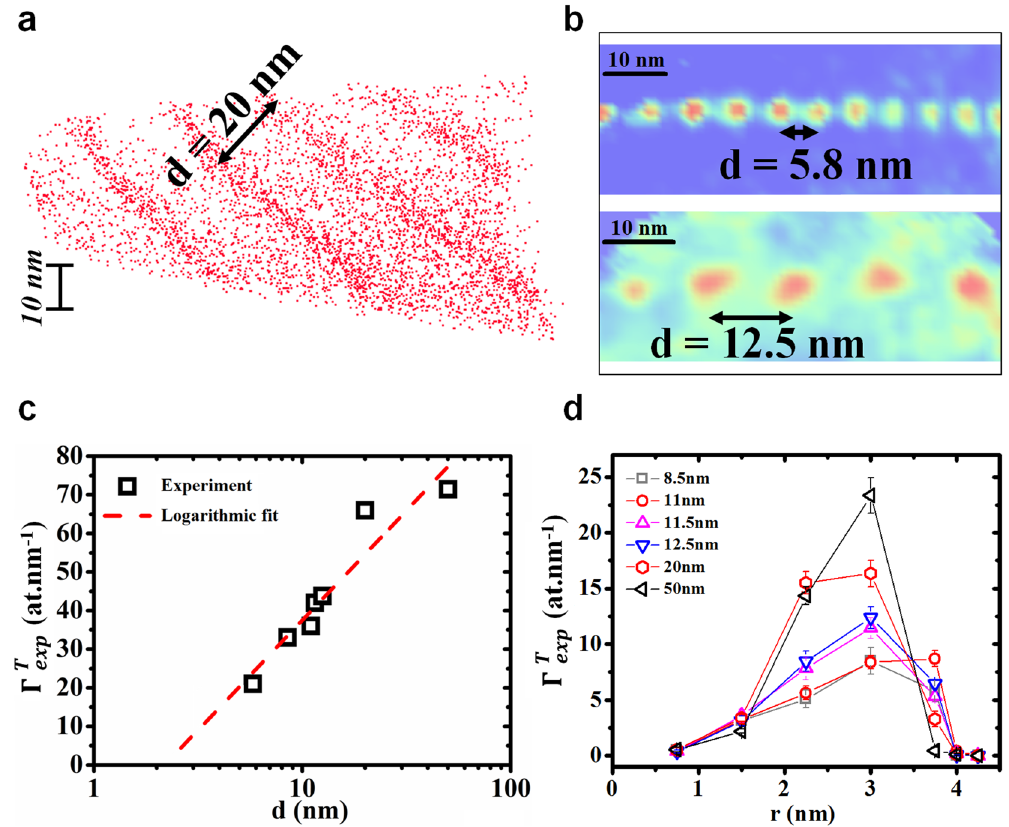
Figure 2. Experimental measurements of impurity segregation at edge-dislocations forming a regular 1D array characterized by an inter-dislocation distance d . ( a) Volume of the bcc-Fe sample analyzed by APT, each dot corresponds to a single Mo atom. ( b ) Impurity 2D concentration maps determined on a plan perpendicular to the dislocation lines in two different dislocation arrays, with d = 5.8 and 12.5 nm. ( c ) Variations of the dislocation Total Excess Number ( Ŵ T exp ) versus d compared to a logarithmic fit (dashed lines). ( d ) Variations of the dislocation Ŵ T exp versus the radius r corresponding to the distance from the dislocation line in the cylindrical geometry, measured in different dislocation arrays exhibiting different d comprised between 8.5 and 50